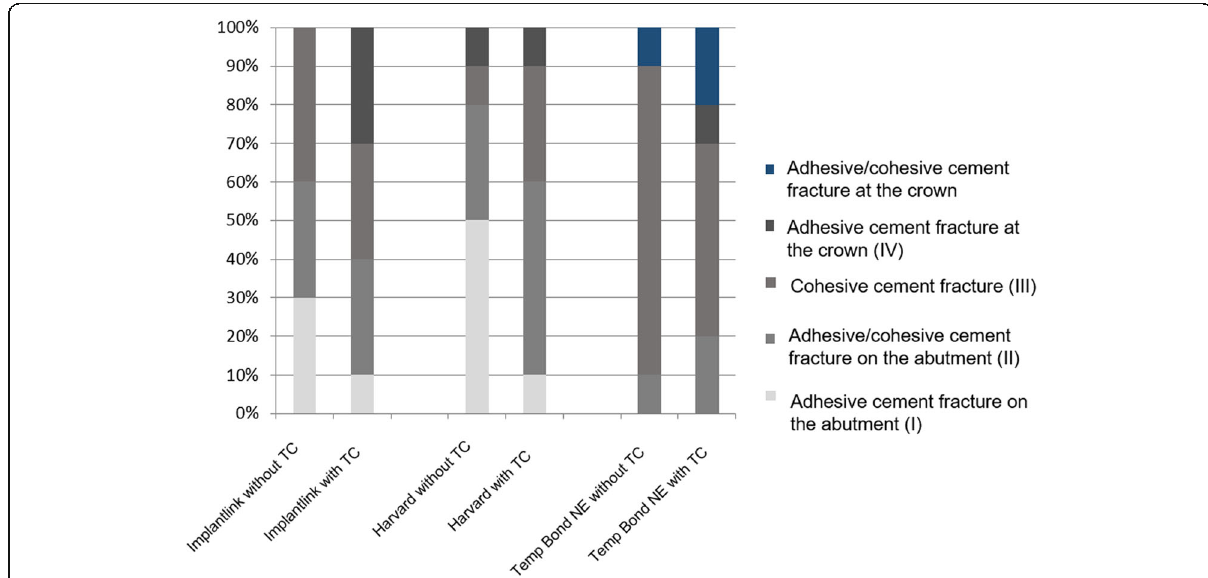
Fig. 6 Fracture mode analysis of the tested temporary